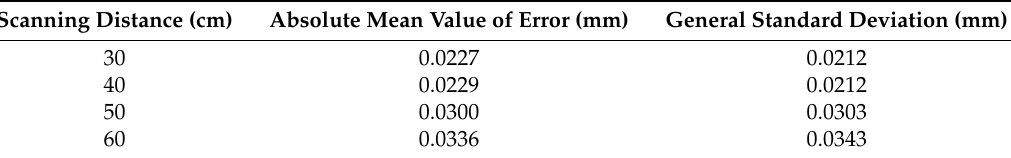
Table 1. Calibration results for the plane calibration board with different distances.